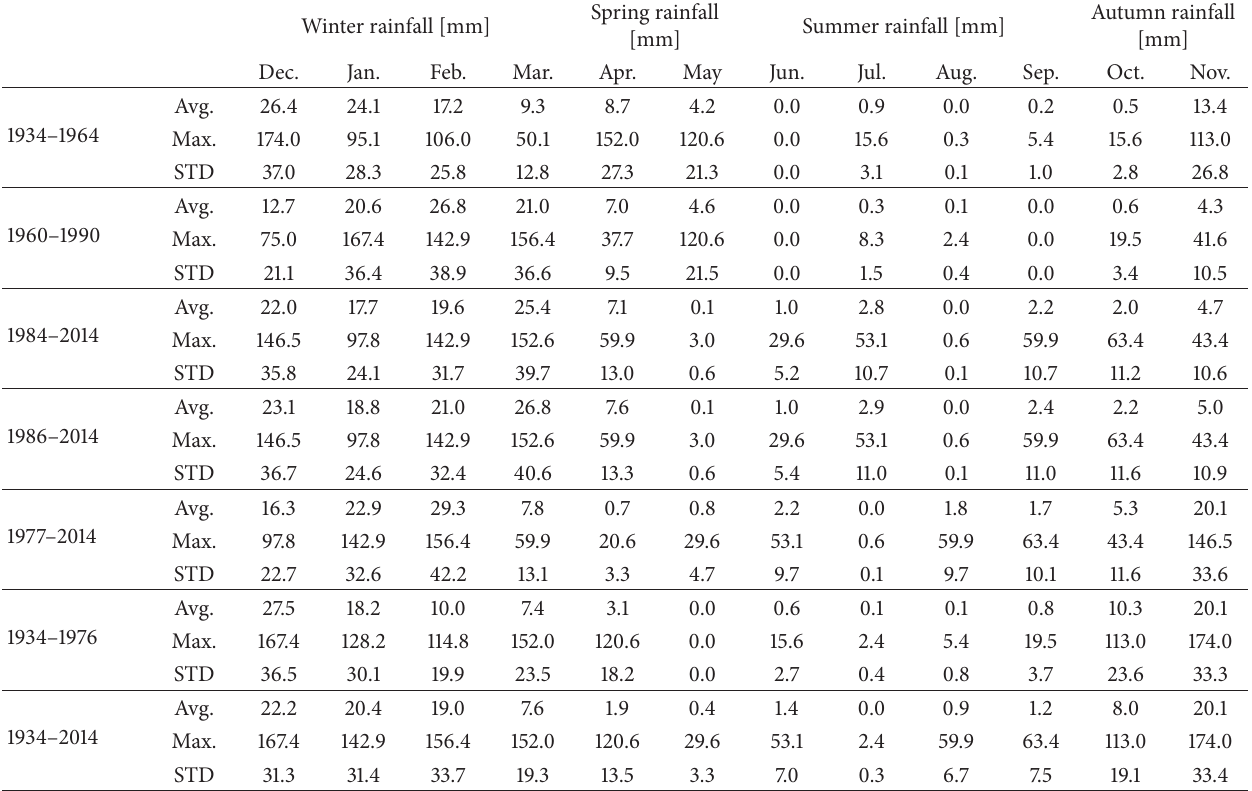
Table2:Averagestatisticsofseasonalrainfallaverage(avg.),maximums(max.),andstandarddeviations(STD)inmmfordifferentaggregated data